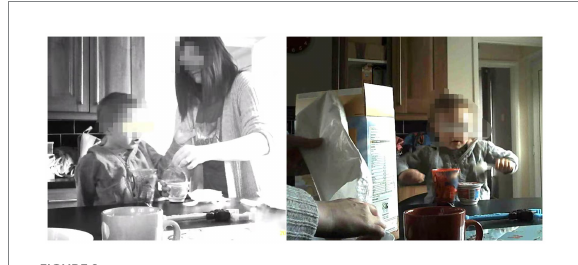
FIGURE 7 Use of standard “adult” size plates to offer children’s meals.